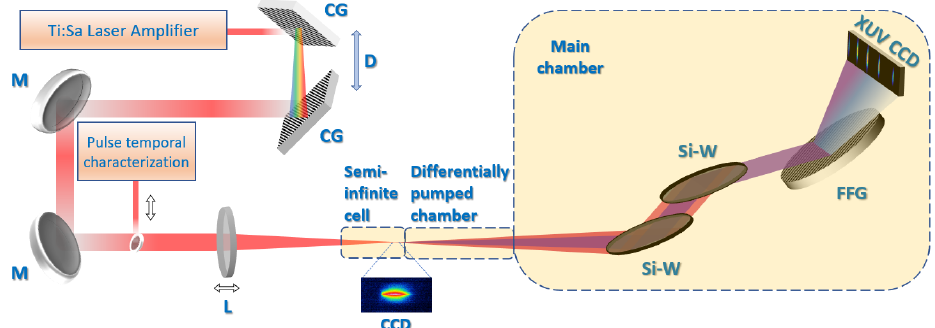
Figure 1. Schematic layout of the HHG experimental setup. Femtosecond IR Ti:Sa laser pulses, chirped by varying the spacing between the compressor gratings (CG), are focused on a semi-infinite Ar gas cell generating coherent XUV harmonic radiation. The XUV beam propagates collinearly with the IR laser beam to the third stage of the setup, where the IR is filtered by two silicon wafers (Si-W). The XUV beam is then dispersed by a flat-field XUV concave grating (FFG) and the plateau XUV harmonics spectra and divergence are imaged by an XUV CCD camera. D: Adjustable grating distance; M: low dispersion fs mirror; L: low dispersion thin-focusing lens. The plasma formation inside the semi-infinite gas cell is imaged by a CCD